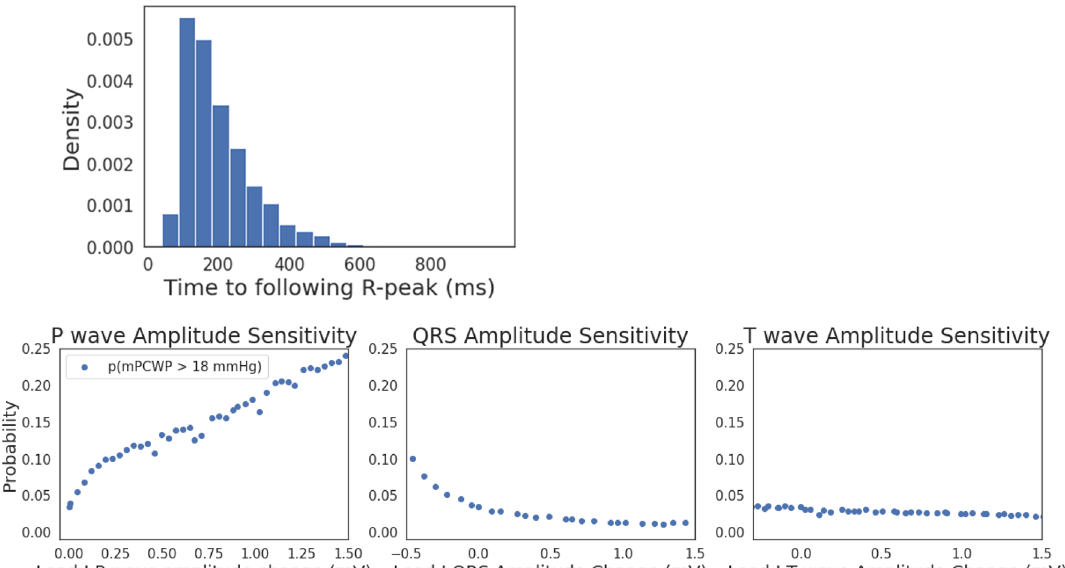
Figure 5. Model sensitivity and saliency map analysis. ( A ) : A saliency-map analysis showing that over 95% of the samples in the test set ECGs with the highest saliency score occur within 400 ms of the subsequent R-peak. ( B ) : Model output as a function of changes to the ECG, indicating that the model output is most sensitive to changes in the P-wave